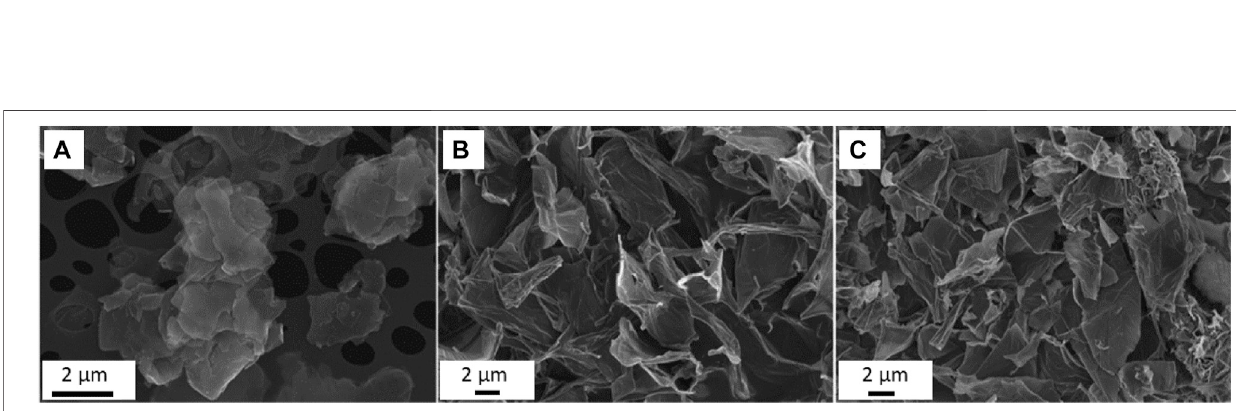
Frontiers in Chemistry |